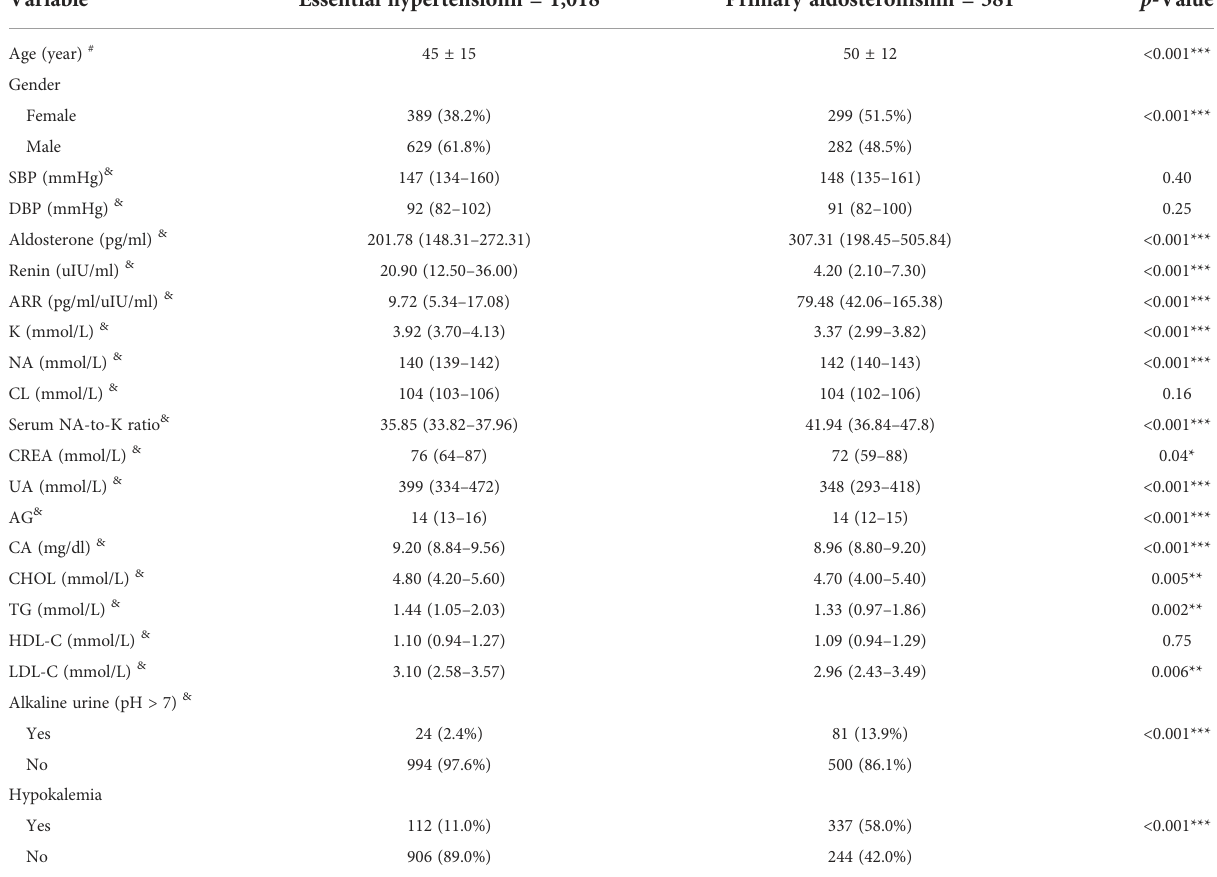
TABLE 1 Baseline clinical and biochemical characteristics of all